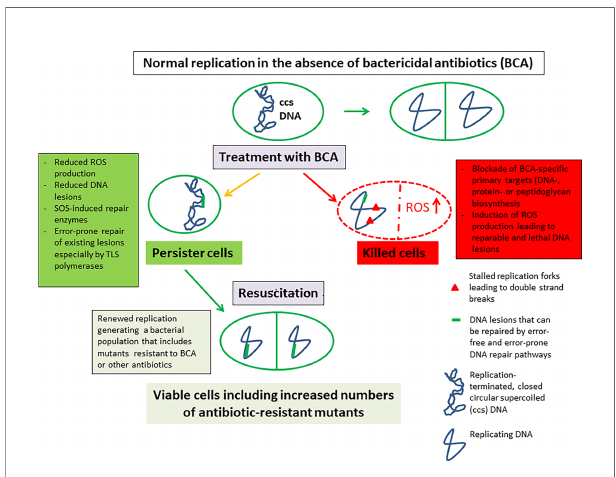
FIGURE 2 | Emergence of mutation-based ABR in persisters. Treatment of a bacterial population with BCAs leads to killing of the majority of the bacterial cells that are in an active DNA replication phase and to the generation of persisters with terminated DNA replication (see Figure 2 and text for details). The ccs chromosomal DNA of the persisters may contain non-lethal DNA damages (green bars) that can be repaired mainly by error-prone DNA repair processes, e.g. by TLS DNA polymerases, however at the expense of increased mutation rates that lead – among others – to ABR